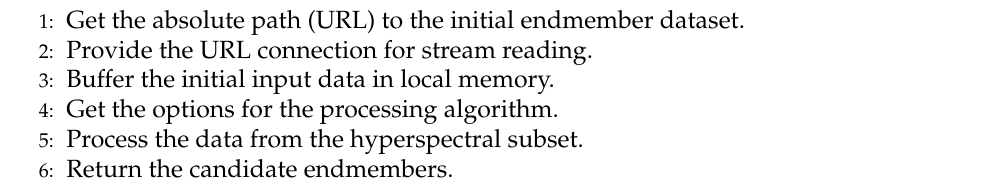
Algorithm 1 Structure for designing the Endmember Extraction UDF